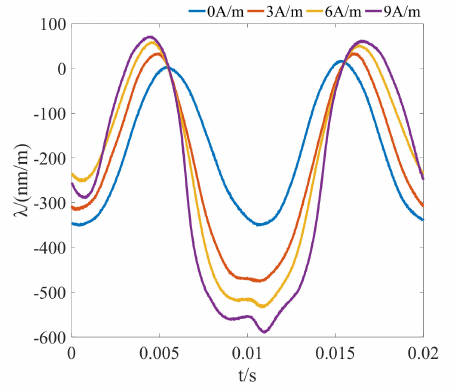
Figure 3. Magnetostriction versus time under di ff erent DC-biased magnetizations ( H dc = 0 A / m, 3 A / m, 6 A / m, 9 A / m, B m = 1.3